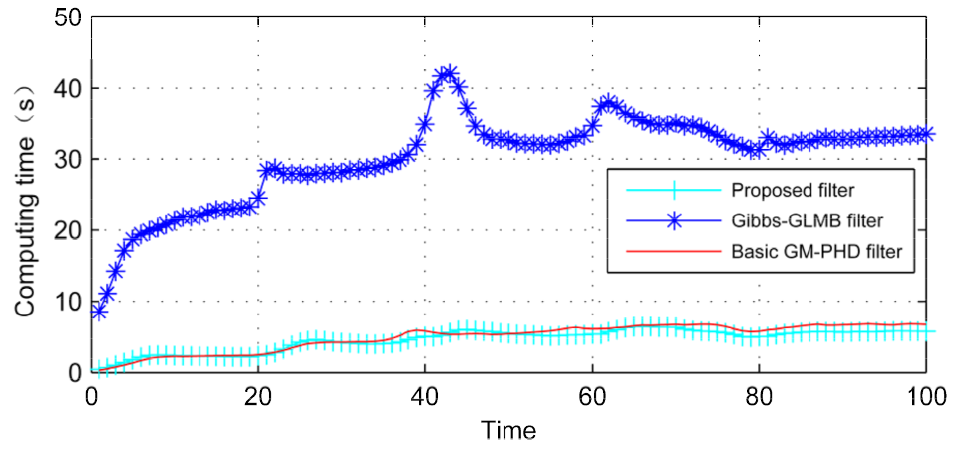
Figure 6. Computing times of different algorithms for 250 sample runs ( λ = 100, p D , k =